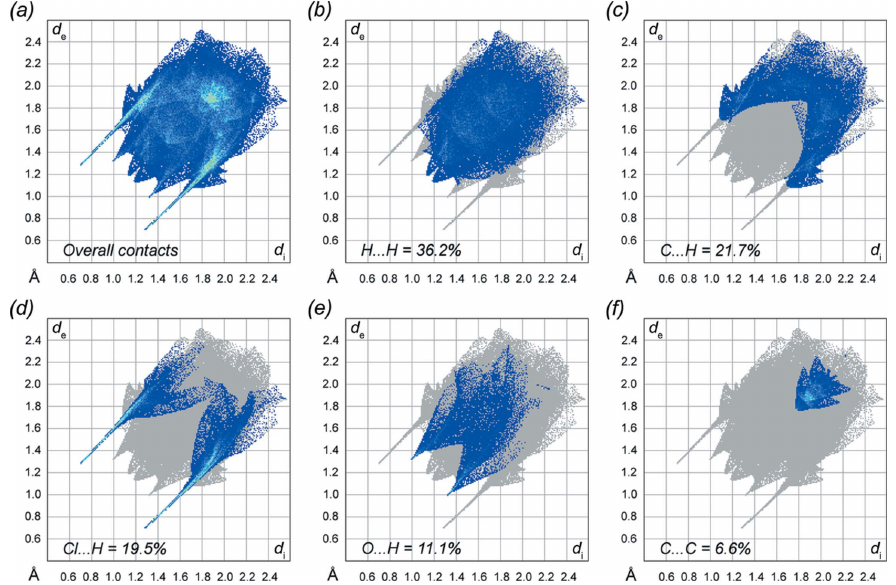
Figure 7 ( a ) The full 2D (two-dimensional) fingerprint plot for IOH (cid:2) Cl, along with separate plots highlighting the five most important and abundant specific contacts: ( b ) H (cid:2)(cid:2)(cid:2) H, ( c ) C (cid:2)(cid:2)(cid:2) H, ( d ) Cl (cid:2)(cid:2)(cid:2) H, ( e ) O (cid:2)(cid:2)(cid:2) H, and ( f ) C (cid:2)(cid:2)(cid:2) C.